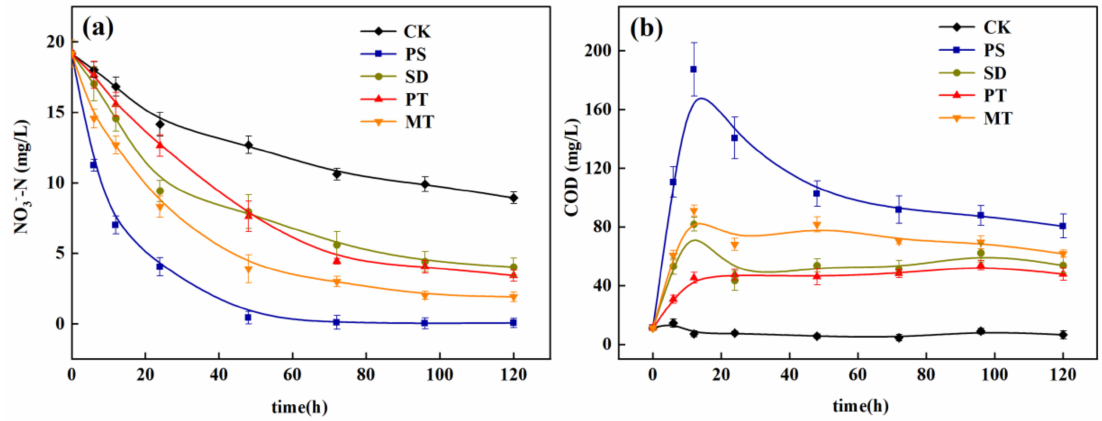
Figure 7. Changes of NO 3 − -N and COD in denitrification process; ( a ) NO 3 − -N; ( b )